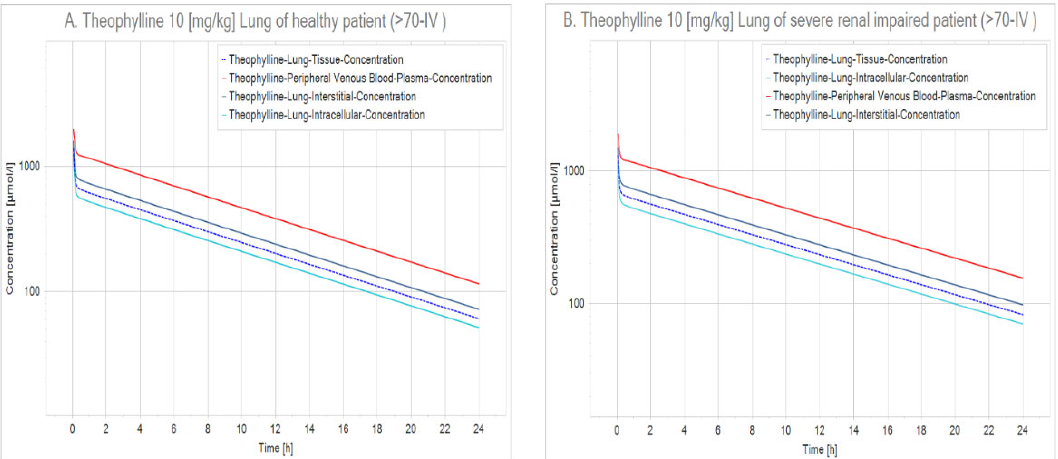
Figure 6. Physiologically based pharmacokinetics model (PBPK) simulation of 10 mg/kg theophylline in the lungs. ( A ) Kinetics in the lung of a healthy patient. ( B ) Kinetics in the lung of a patient with renal impairment. This figure shows that theophylline clearance is sensibly delayed in patients with impaired renal function. When comparing both charts, a decrease in the inclination of the lung concentration curves can be observed for the patient with renal failure. Noteworthy, renal elimination is the main route to excrete theophylline and consequently, a reduced clearance increases the time the drug remains in the body increasing the possibility of unwanted side effects (Supplementary Materials Table S2).